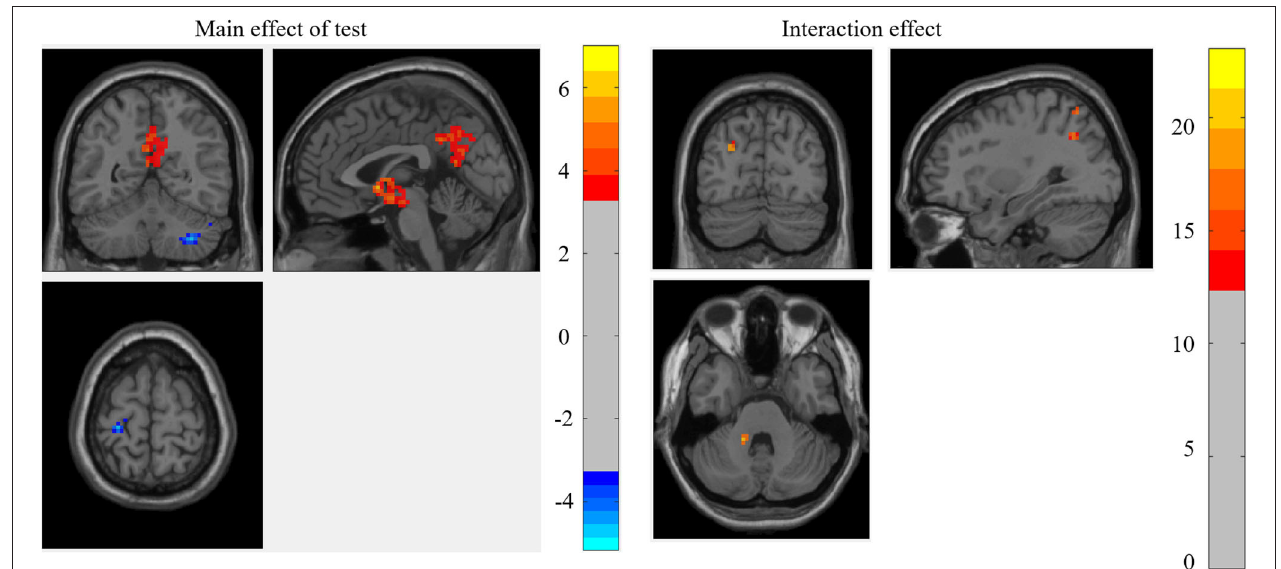
FIGURE 2 | The brain regions that were significant in the mixed-effect analysis of the weighted graph.